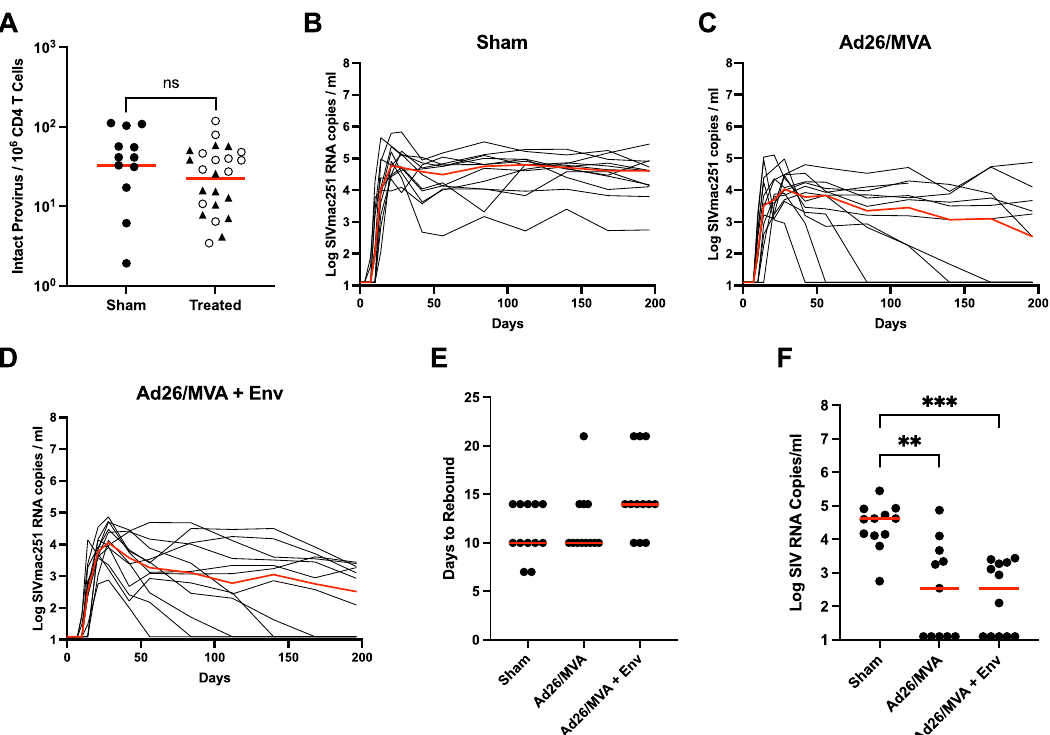
Fig. 4 Control of rebound viremia following antiretroviral therapy interruption. A Intact proviruses per million CD4 + T cells quanti fi ed via an SIV-optimized digital-droplet PCR based Intact Proviral DNA Assay (IPDA) measured at week 72 post-infection, directly before ART interruption. Treatment groups were aggregated into a single group and compared to sham controls. Solid Triangles are animals in the Ad26/ MVA treatment group and open circles are animals from the Ad26/MVA + Env treatment group. Red lines show the geometric mean. Statistical signi fi cance was derived from a nonparametric Mann – Whitney U Test. B – D Plasma viral loads (in log SIV mac251 gag copies/ml plasma) for each study group 198 days following ART interruption at week 72 post-infection. Red curves indicate median values. E Number of days until rebound infection was detected after ART interruption at week 72 post-infection. Red lines indicated median values. Statistical signi fi cance was determined from a Kruskal – Wallis test with Dunn ’ s correction for multiple comparisons. F Plasma viral loads detected at day 198 post-ART interruption, for each treatment group and sham animals. Red lines denote median values. Statistical signi fi cance was determined from a Kruskal – Wallis test with Dunn ’ s correction for multiple comparisons. * < 0.05, ** < 0.01, *** < 0.001, **** <